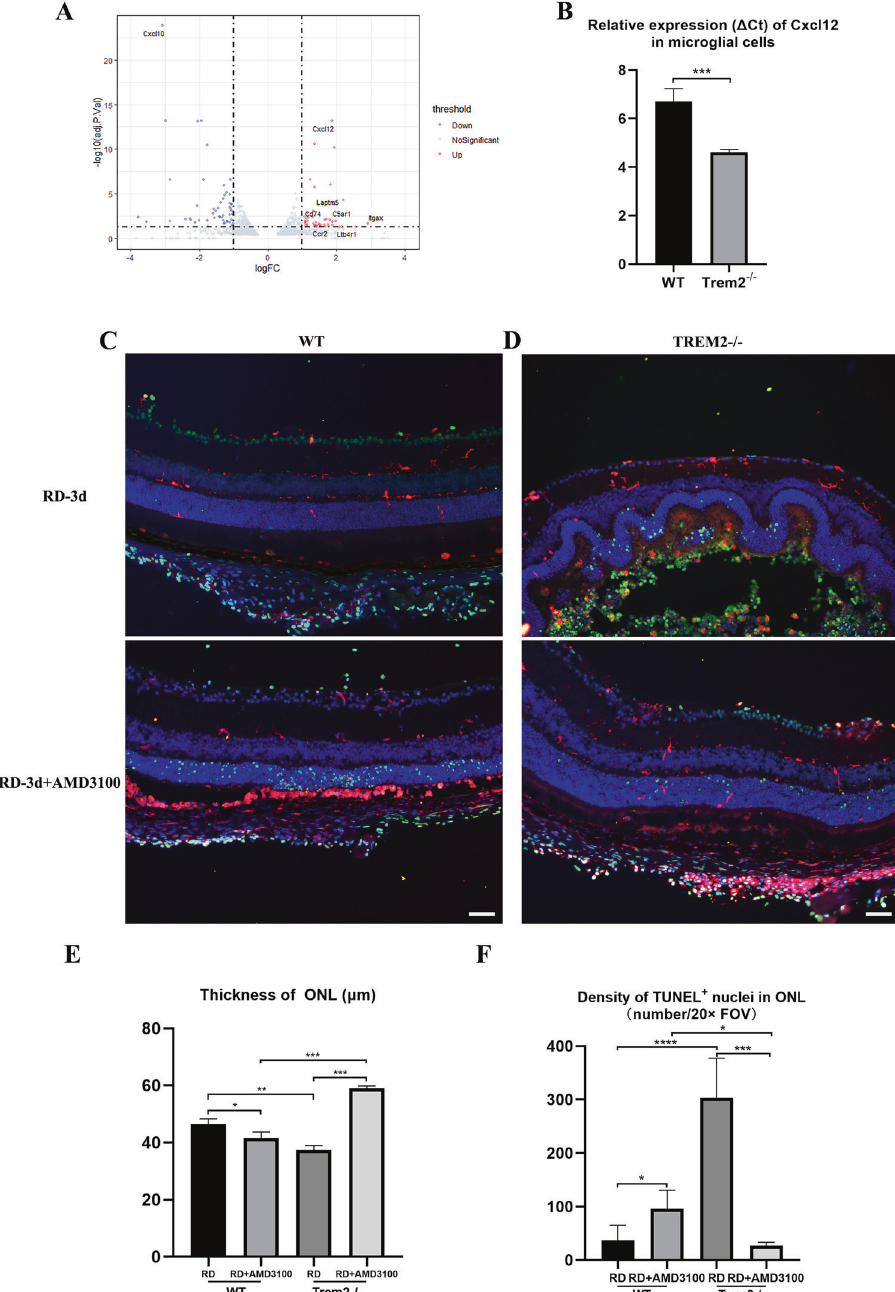
Fig. 5 Trem2 de fi ciency upregulates Cxcl12 expression potentiating photoreceptor cell death. A Volcano plot showing that the expression level of Cxcl12 is increased at 12 h post-RD in Trem2 − / − mouse. B The expression of Cxcl12 is increased in Trem 2-de fi cient microglial cells at resting state. Co-immunolabeling for TUNEL + nuclei (green) and IBA1 + cells (red) at 3 d post-RD in WT ( C ) and Trem2 − / − ( D ) mouse treated with and without AMD3100. E , F Quantitative analyses demonstrate that compared to control groups, the AMD3100 treatment signi fi cantly reduced immune cell in fi ltration, the number of TUNEL + cells in the ONL and the thinning of ONL at 3 d post-RD in the Trem2 − / − mice. Column heights and error bars indicate mean ± SD. ns, not signi fi cant, * p < 0.05, ** p < 0.01, and *** p < cells from untreated WT and Trem2 − / − retina using magnetic beads coupled CD11b antibody and extracted total RNA. The purity of the cells was con fi rmed by the enrichment of microglial homeostatic genes Cx3cr1 and Tmem119 (Additional fi le 2: Fig. S4).